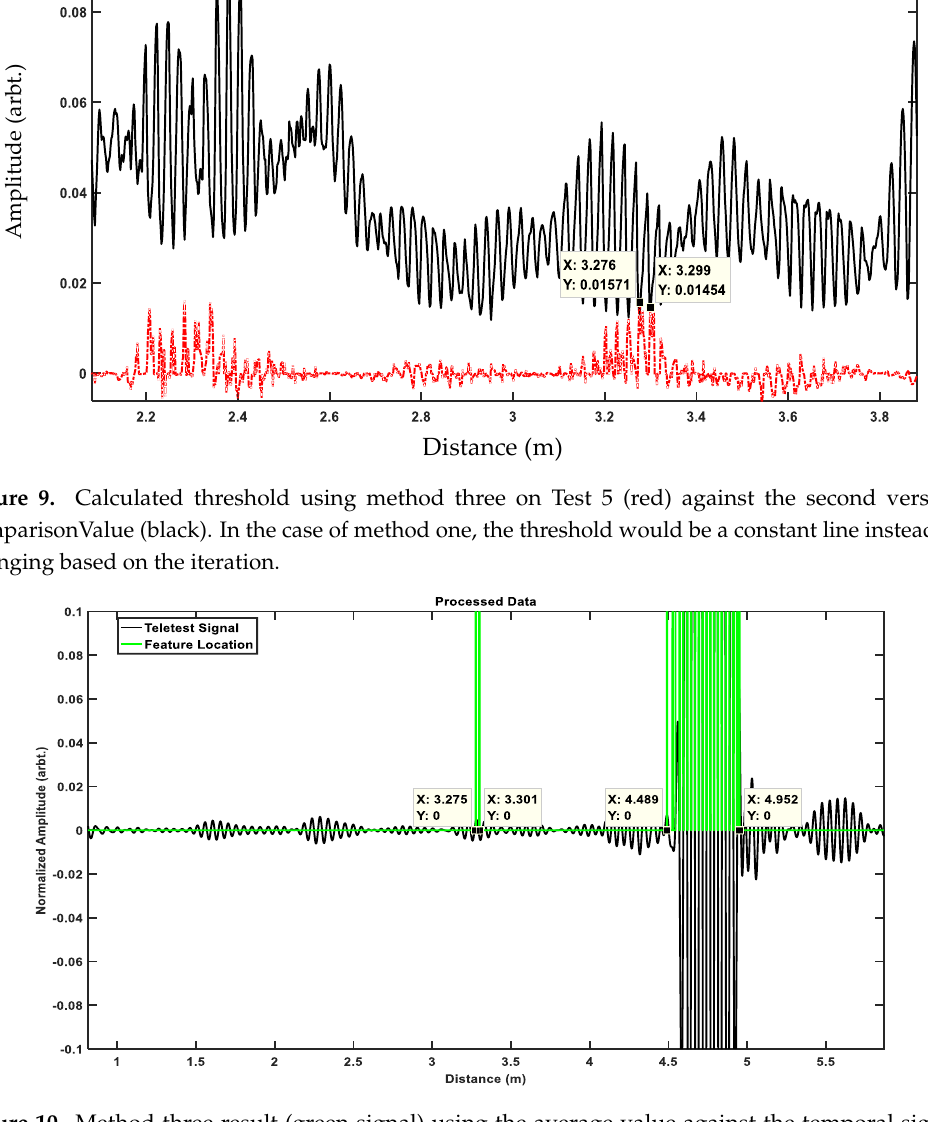
Figure 10. Method three result (green signal) using the average value against the temporal signal (black) for testing a 2% CSA defect.